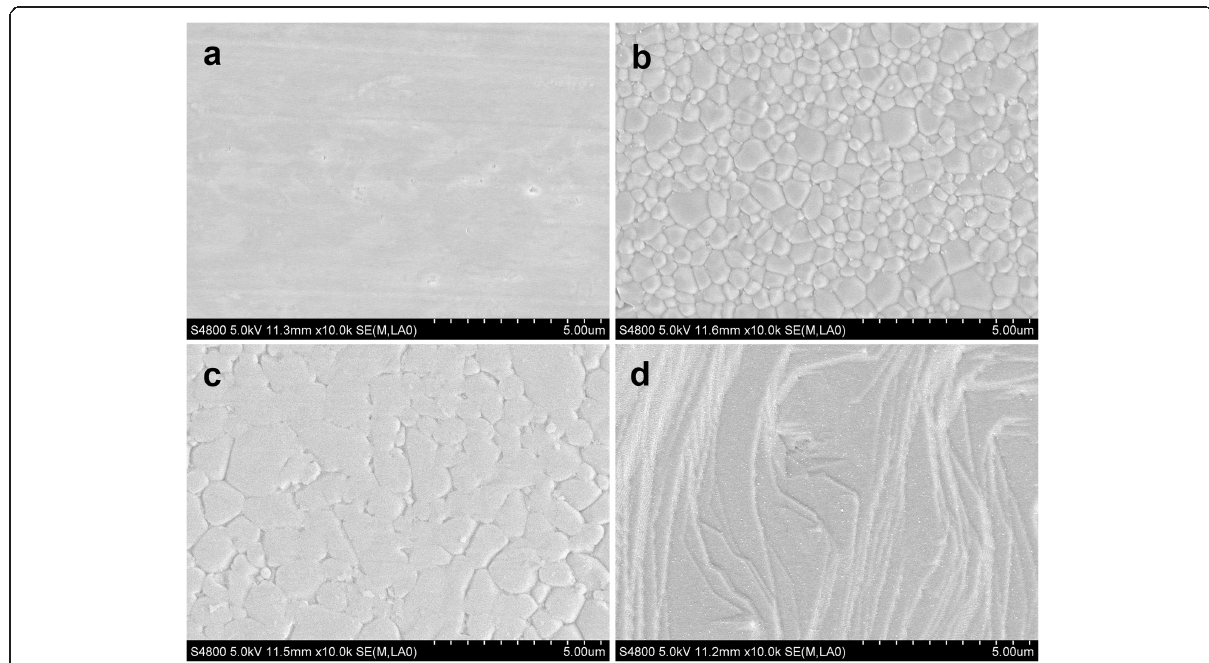
Fig. 5 SEM images of ceramic bracket slot, at 10 k×: a CCB; b CA; c C7; d IC